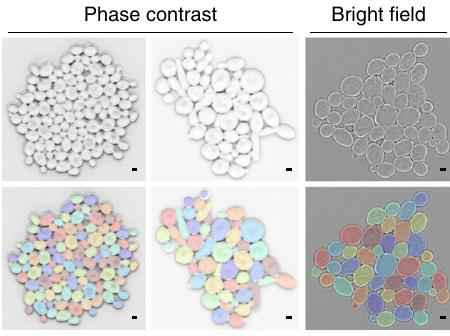
Fig. 2 Overview of the YeaZ training data set. Shown are examples of raw images acquired with phase contrast or bright- fi eld microscopy (upper row) and corresponding manual annotations (lower row). Phase contrast image inverted for better visualization. Scale bar: 2 μ